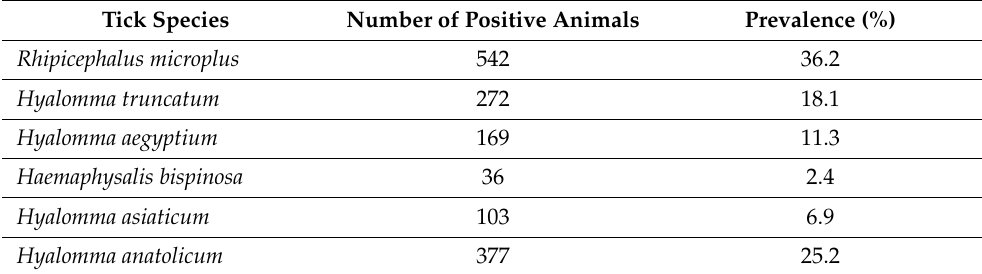
Table 2. The overall prevalence of ticks in sheep and goats of KPK province, Pakistan.